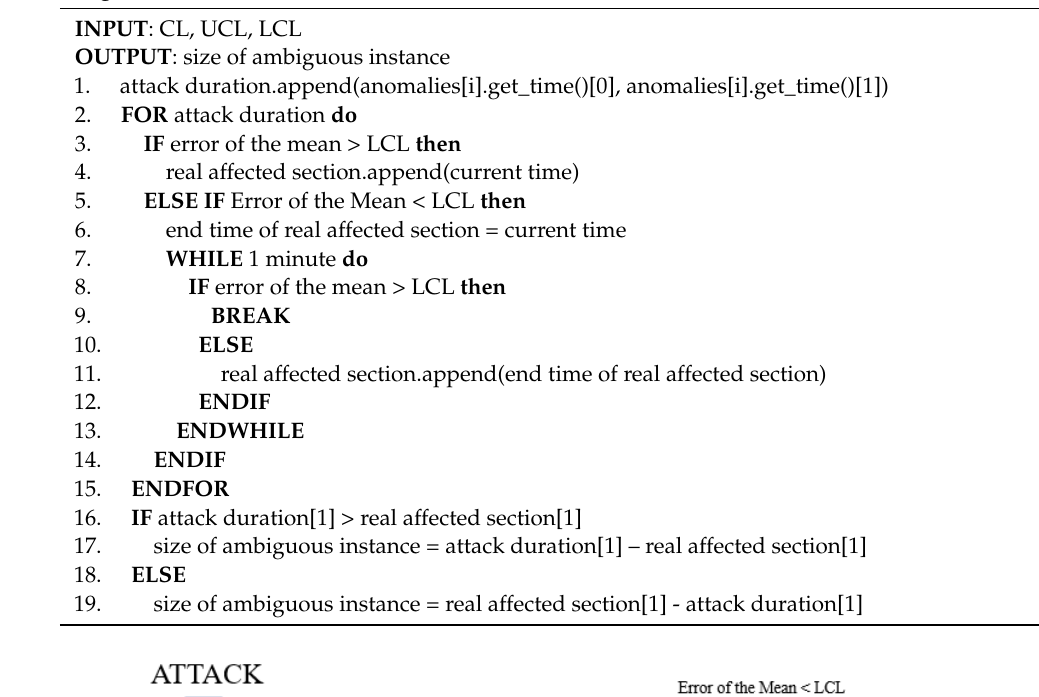
Algorithm 1. Definition of the real affected section